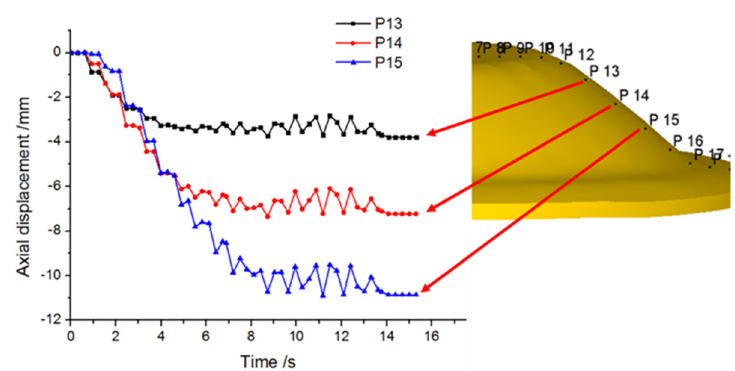
Figure 5. Axial displacement of the sampling point in Zone 3.